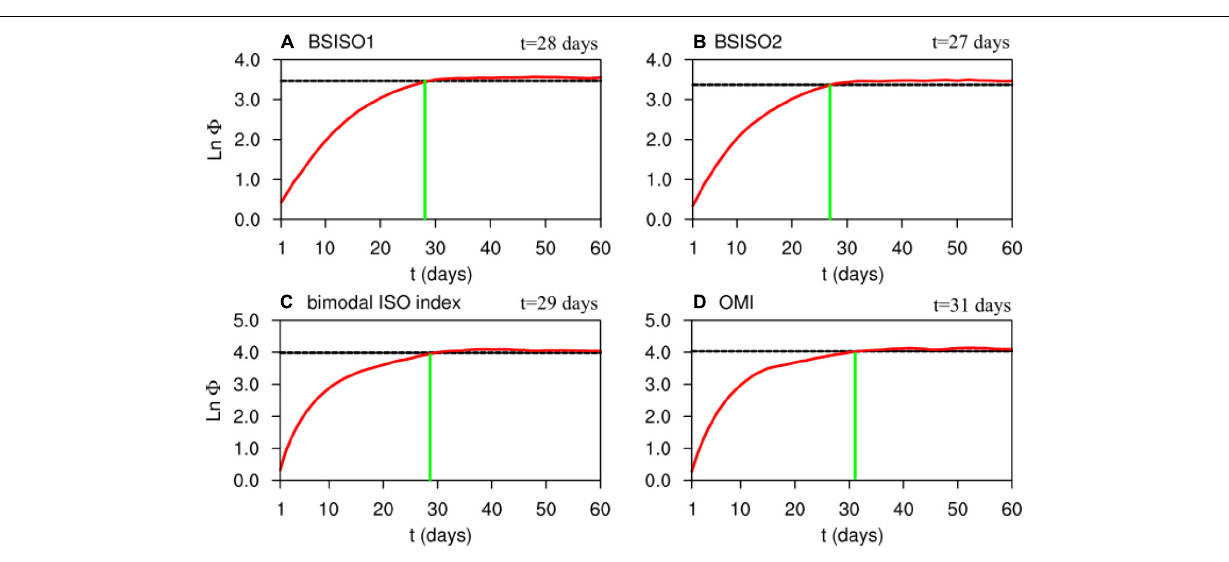
FIGURE 3 | Same as Figure 2 , but for (A) BSISO1 index, (B) BSISO2 index, (C) bimodal ISO index, and (D)